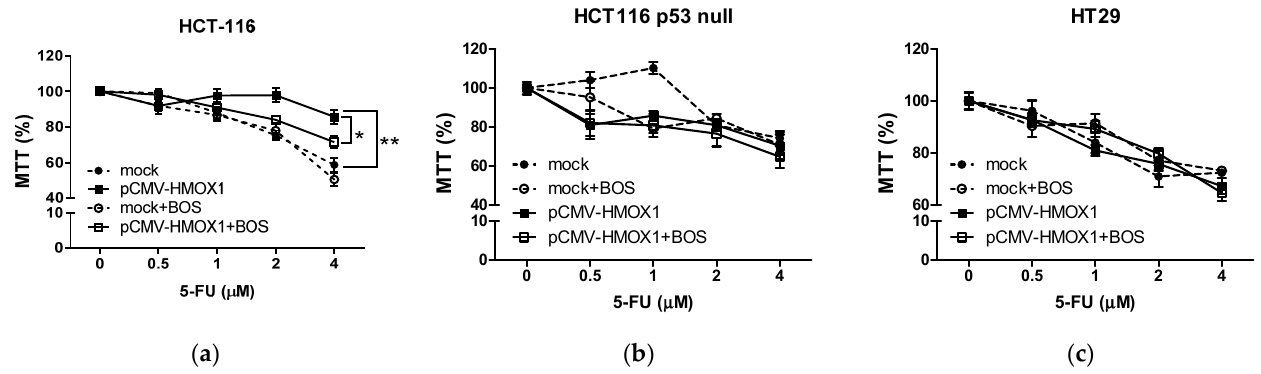
Figure 8. Influence of HO-1 overexpression on therapy resistance in CRC. As described in the Materials and Methods section, cells were seeded in 96 well-plates, transfected with vector or pCMV6- HMOX1 plasmid, and treated with increasing doses of 5-FU (0–4 Μ m) during 72 h in the presence or absence of 10 μ M bosentan. The viability of cells was analyzed using the MTT assay in ( a ) HCT-116, ( b ) HCT-116 p53 null, and ( c ) HT-29 cells. Data represent the mean ± SD of two experiments performed in quadruplicate. *, p < 0.05; **, p < 0.01.